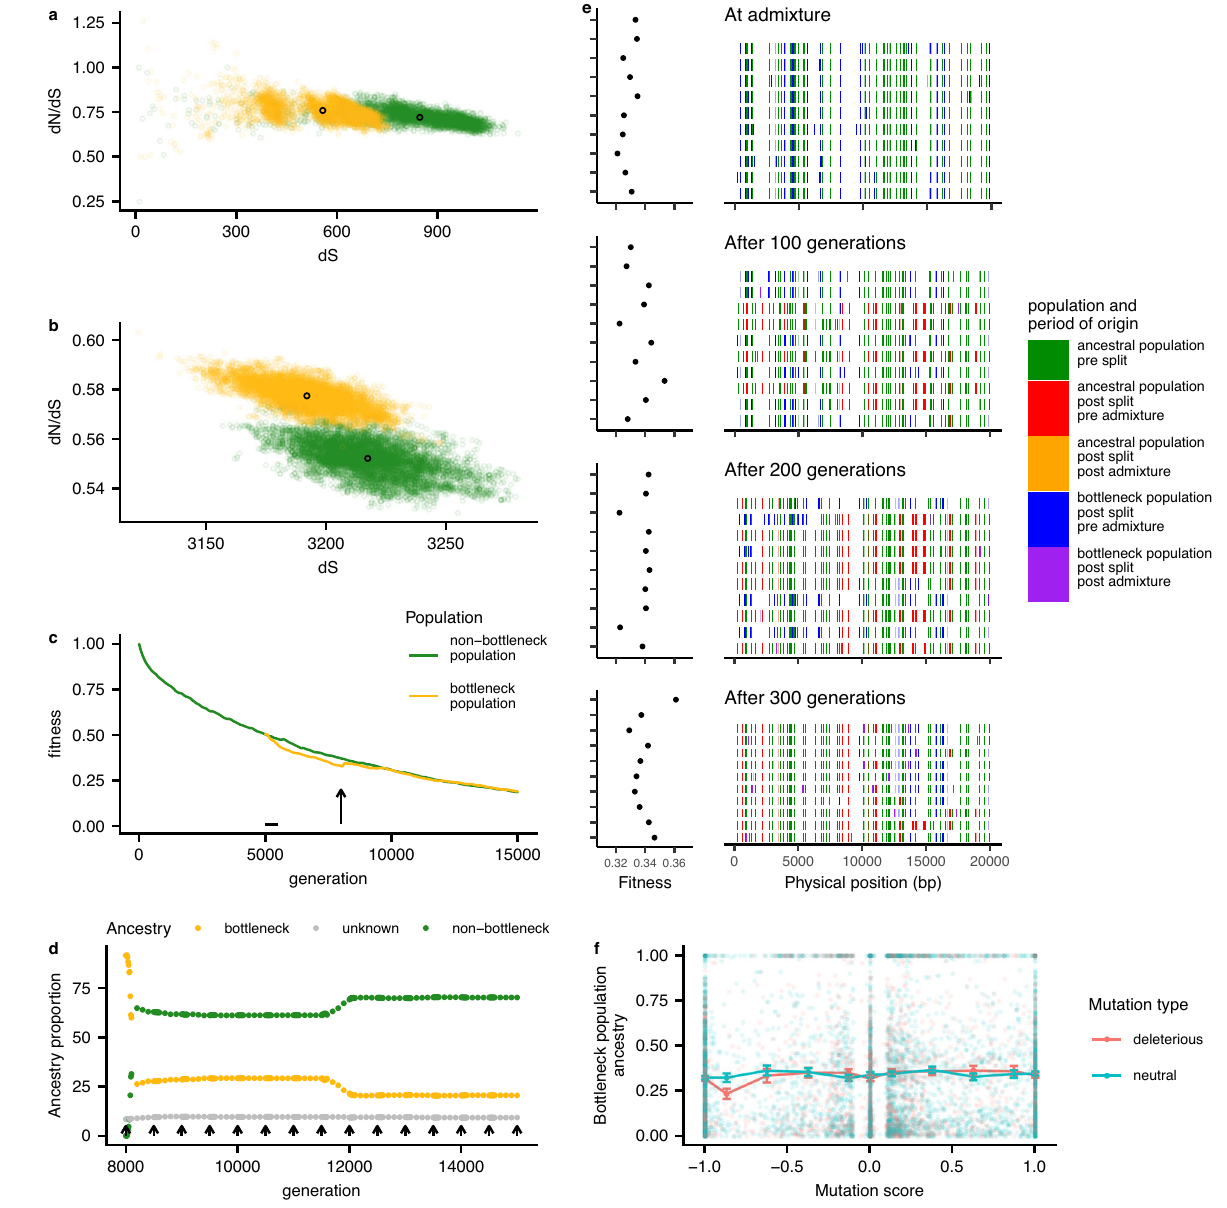
Fig. 4 | Simulations of populations under bottlenecks and admixture. a Within populationdN/dSand b dN/dScalculatedtotheancestormeasuredatgeneration 8000. Semi opaque points show pairwise distances; solid points indicate popu- lation means. c Population average fi tness shown during the generations of the simulation, with bottleneck starting at generation 5000 (horizontal line) and admixture at generation 8000 (arrow). d Proportion of bottleneck and non- bottleneck ancestry in the bottleneck population, for the generations after the beginning of admixture. Sites with unknown ancestry are shown in gray. Each arrowcorresponds to the migrationof one strain. e Ancestry painting in a sample